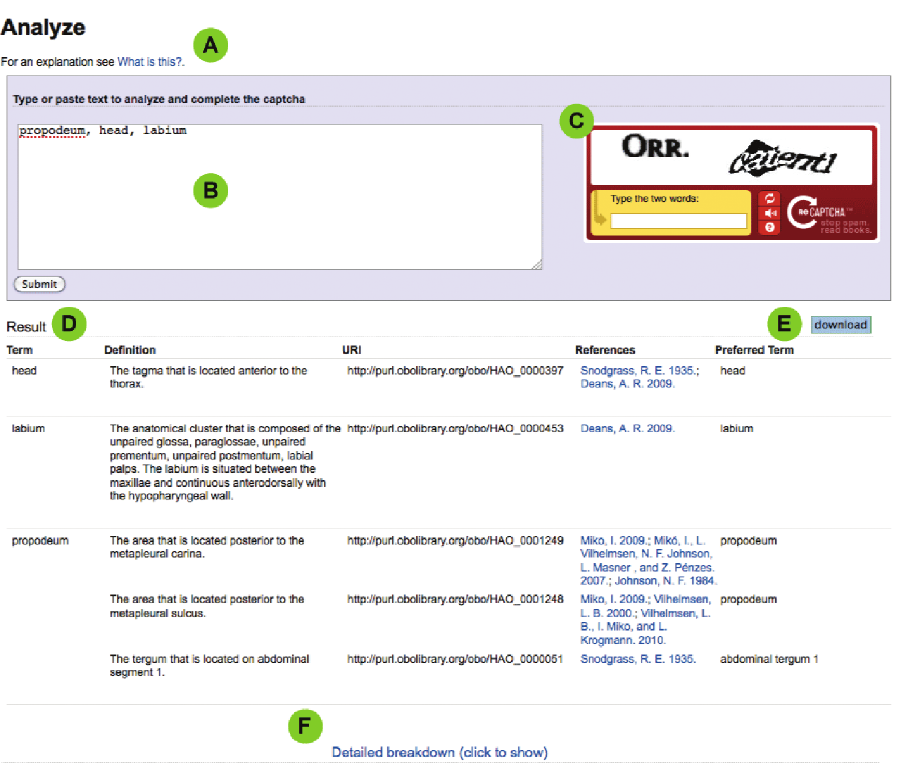
Figure 2. Using and interpreting results from the analyzer. See Using the “analyzer” tool for